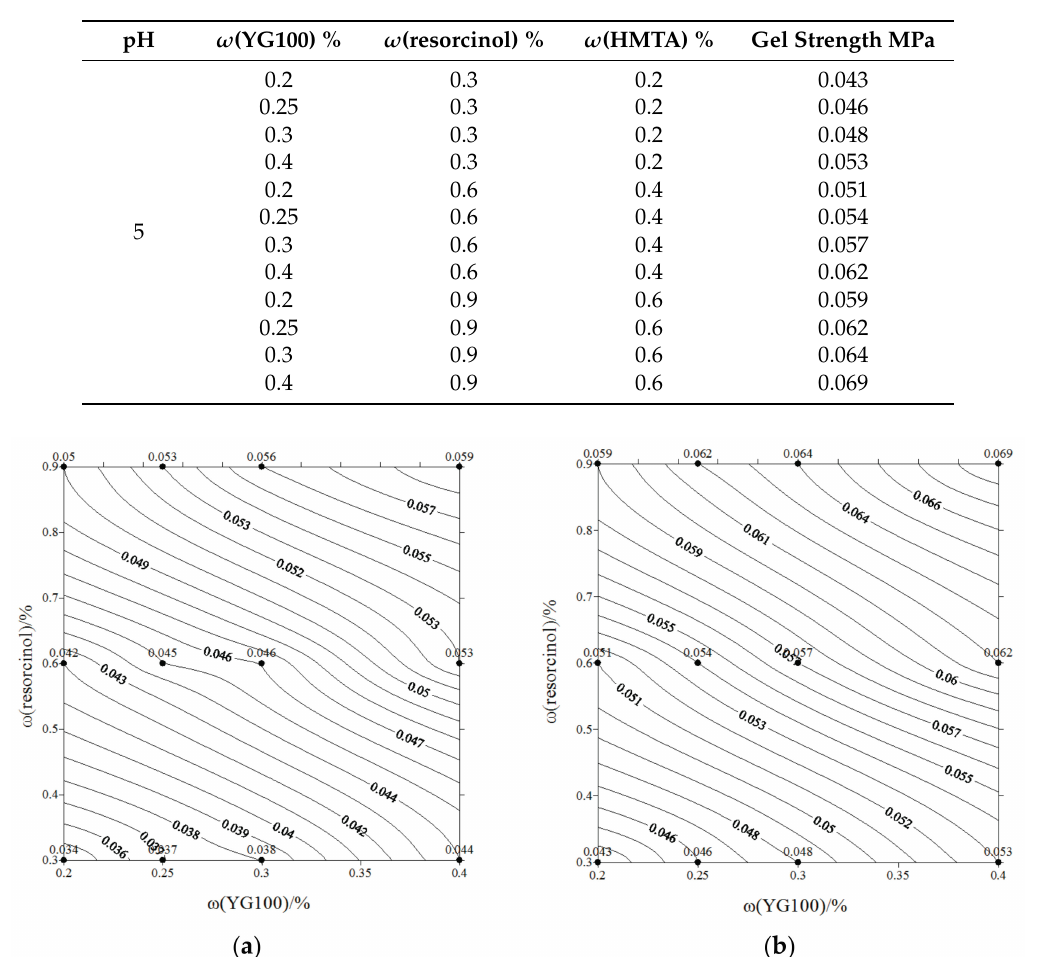
Figure 4. Contour map of the polymer gel breakthrough vacuum value ( ω (resorcinol) : ω (HMTA) = 1.5:1). ( a ) pH = 6; ( b ) pH =